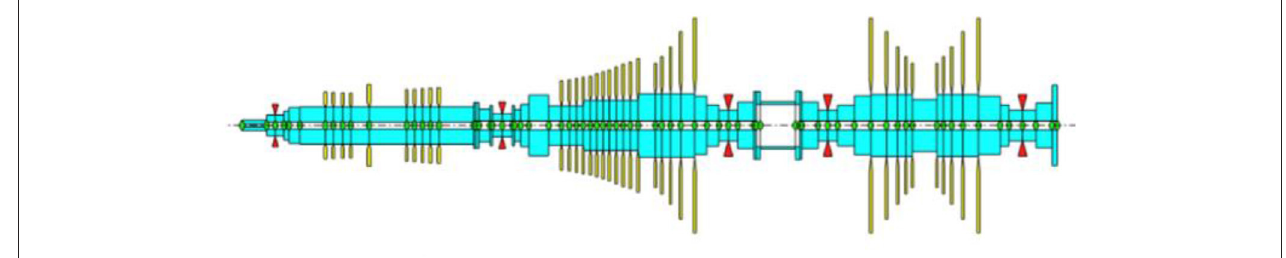
FIGURE 12 | Schematic illustration of simplified FE model of the complete steam turbine.